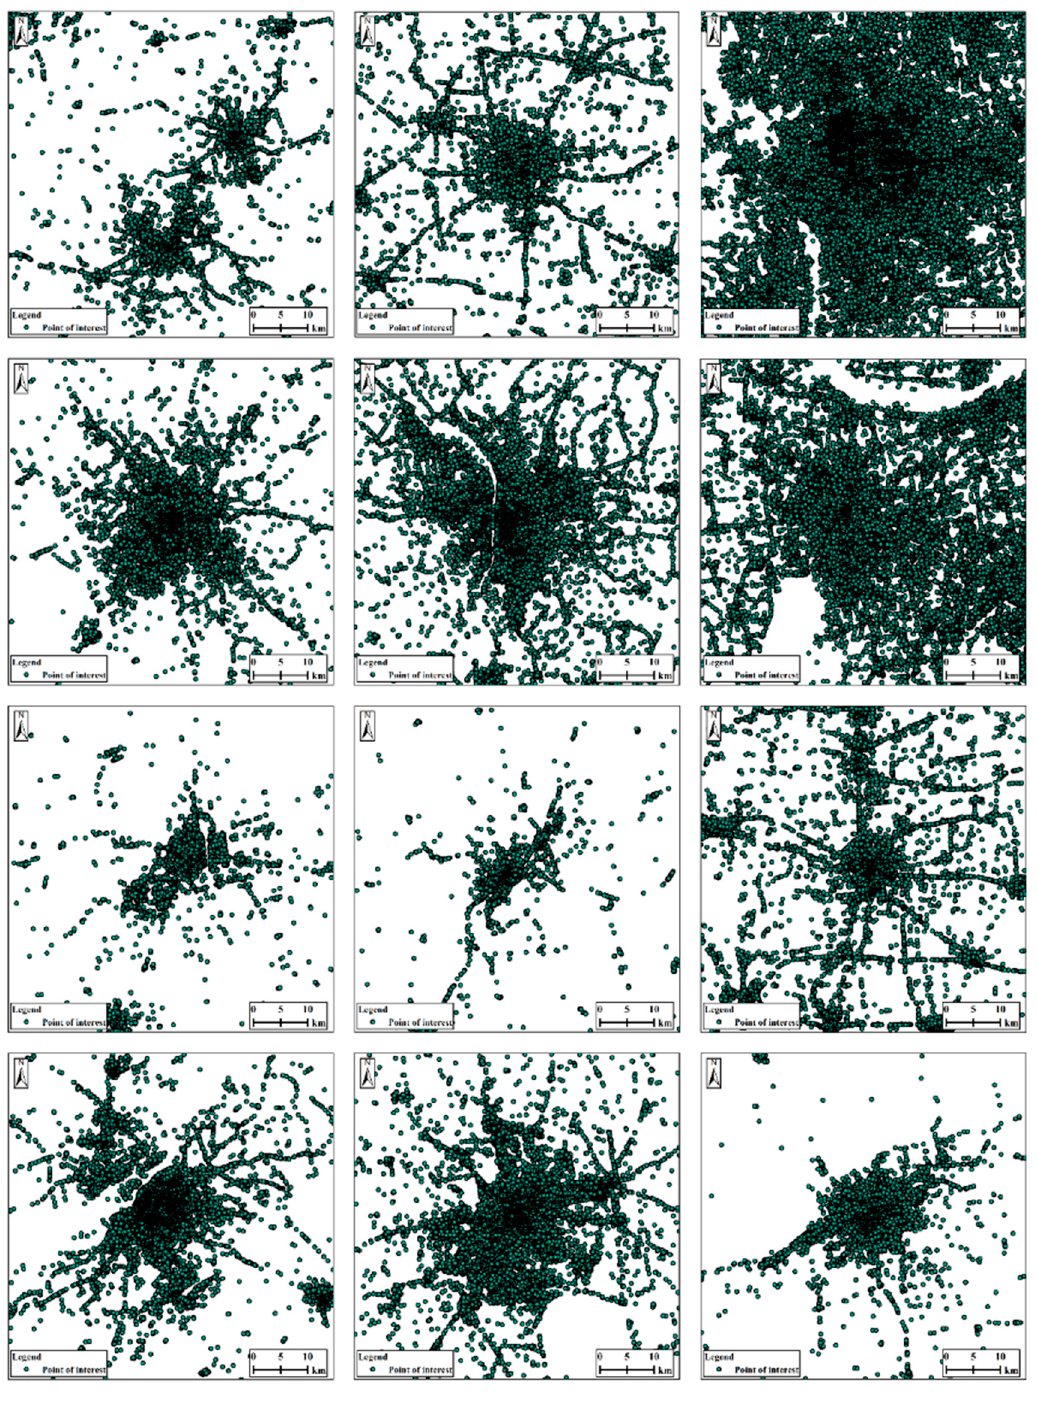
Figure A4. Figure A4. Map of the point of interest (POI) data for the 32 Chinese cities.